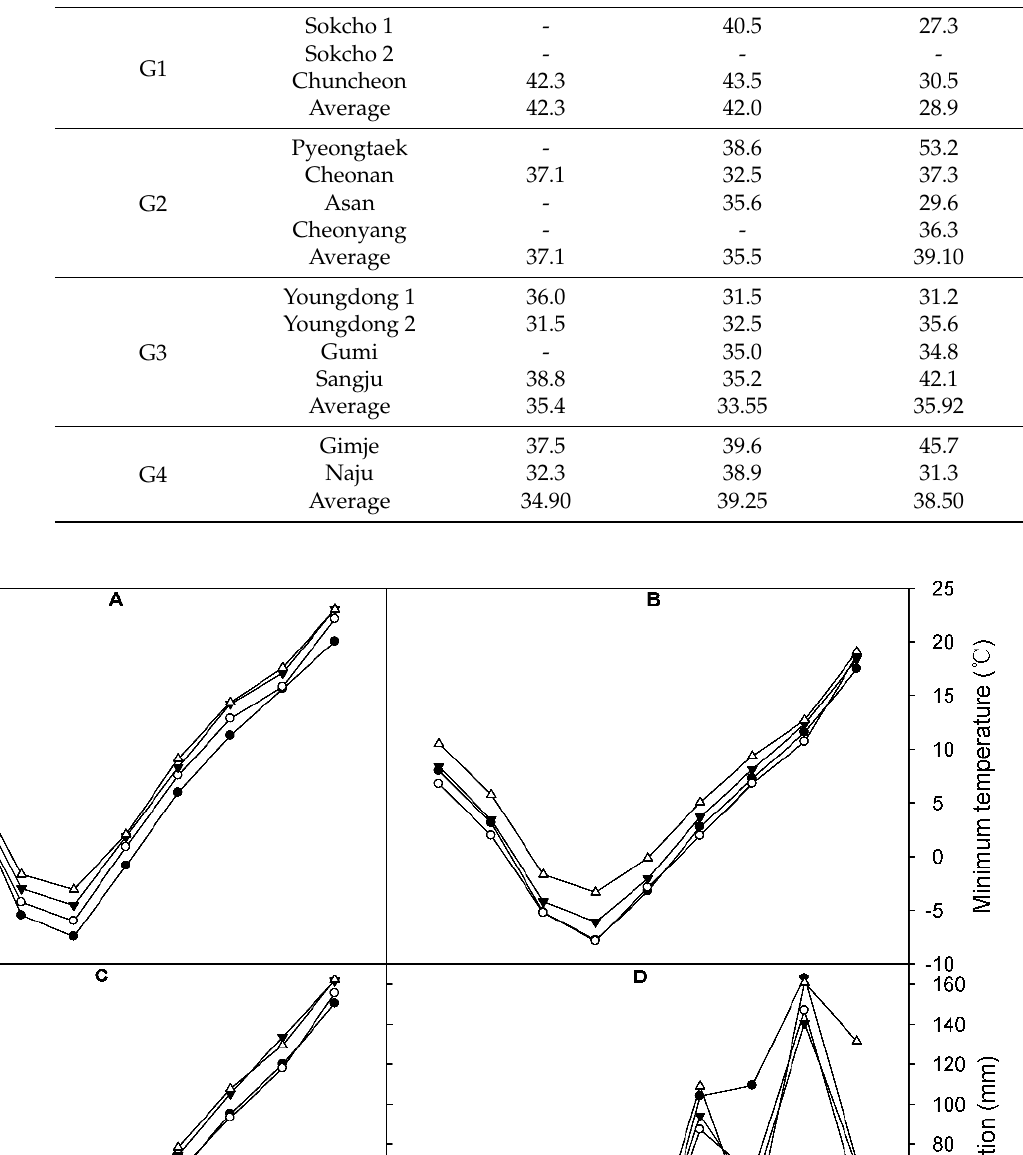
Figure 3. Maximum ( A ), minimum ( B ), daily average temperatures ( C ), and precipitation ( D ) in different group areas during experiment period in October 2021 to June 2022. Barley is most sensitive to weather variation early in the season, which can affect the spikelet number and early grain filling [21,26]. In this study, the growth and yield of